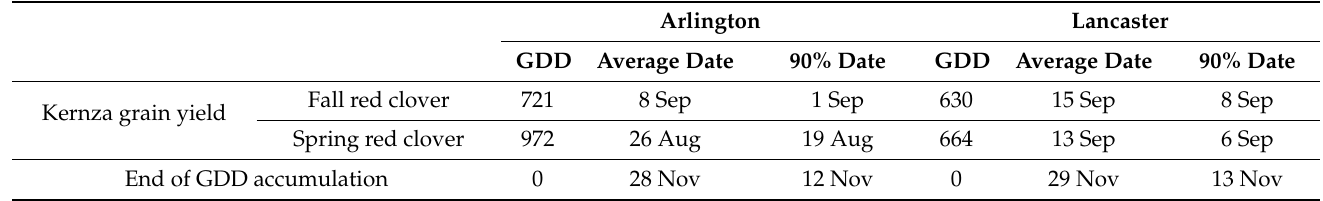
Table 3. Growing degree days (GDD), 30-year mean optimal planting date, and 90% probability date (the planting date that will optimize yields 90% of the time) of Kernza grain yield, and the end of GDD accumulation for Arlington and Lancaster, WI, USA. Arlington